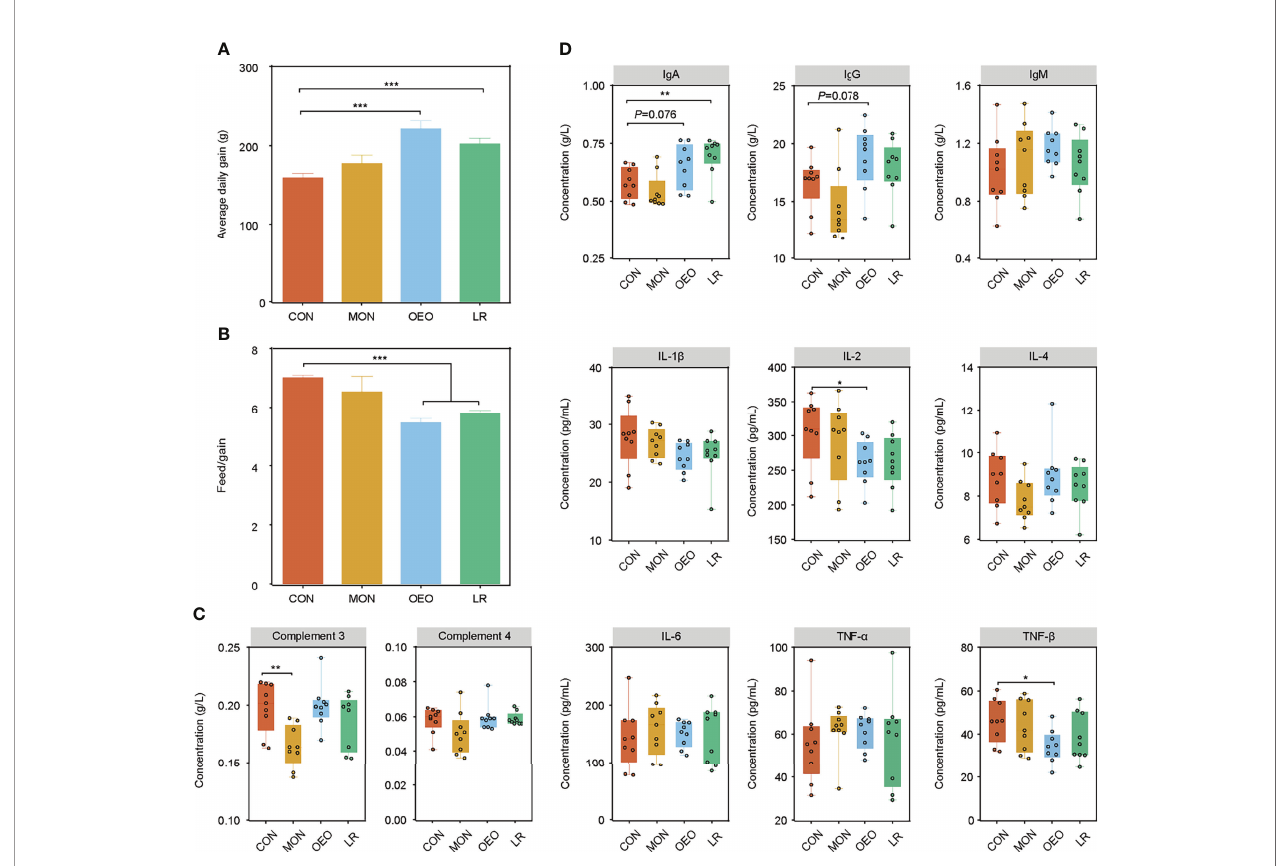
FIGURE 1 | Effect of OEO and LR on the growth performance and serum parameters in sheep. (A, B) were results of growth performance of average daily gain (ADG), and feed/gain ratio (F/G). (C, D) The complements, immunoglobulins and pro-in fl ammatory cytokines contents in serum of sheep by different diet treatments. CON, a basal diet; MON, a basal diet plus 0.5 g/head/d monensin; OEO, a basal diet with 52 mg/head/d oregano essential oil; LR, a basal diet supplemented with 10 g/head/d Lactobacillus reuteri. Asterisks indicate signi fi cant difference between the trial group and the CON group (*0.01 < P ≤ 0.05; **0.001 < P ≤ 0.01; *** P ≤ 0.001). IL , interleukin; TNF , Tumor necrosis